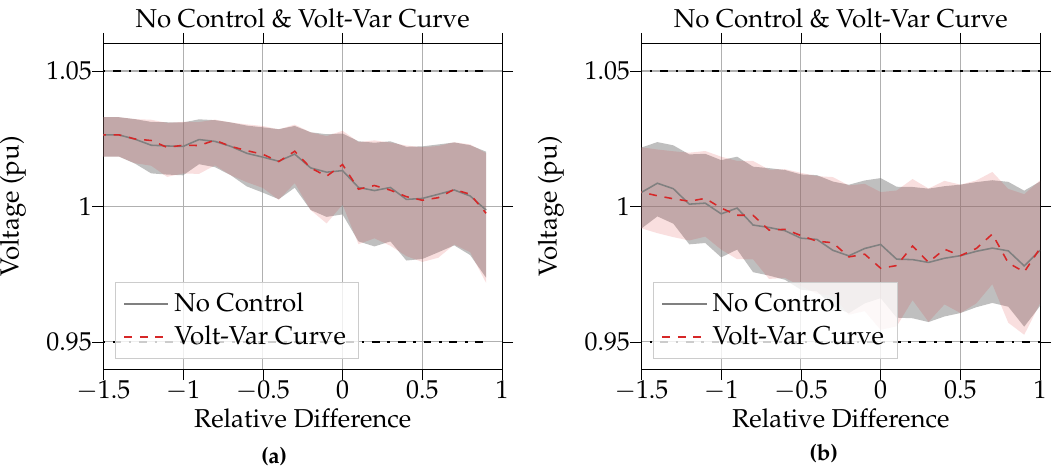
Figure 9. Implementation of the malicious Volt-Var Curves (VVC), that stipulate the injection of reactive power at high voltage, did not result in any voltage issues. ( a ) EPRI K1 Feeder; ( b ) Unnamed